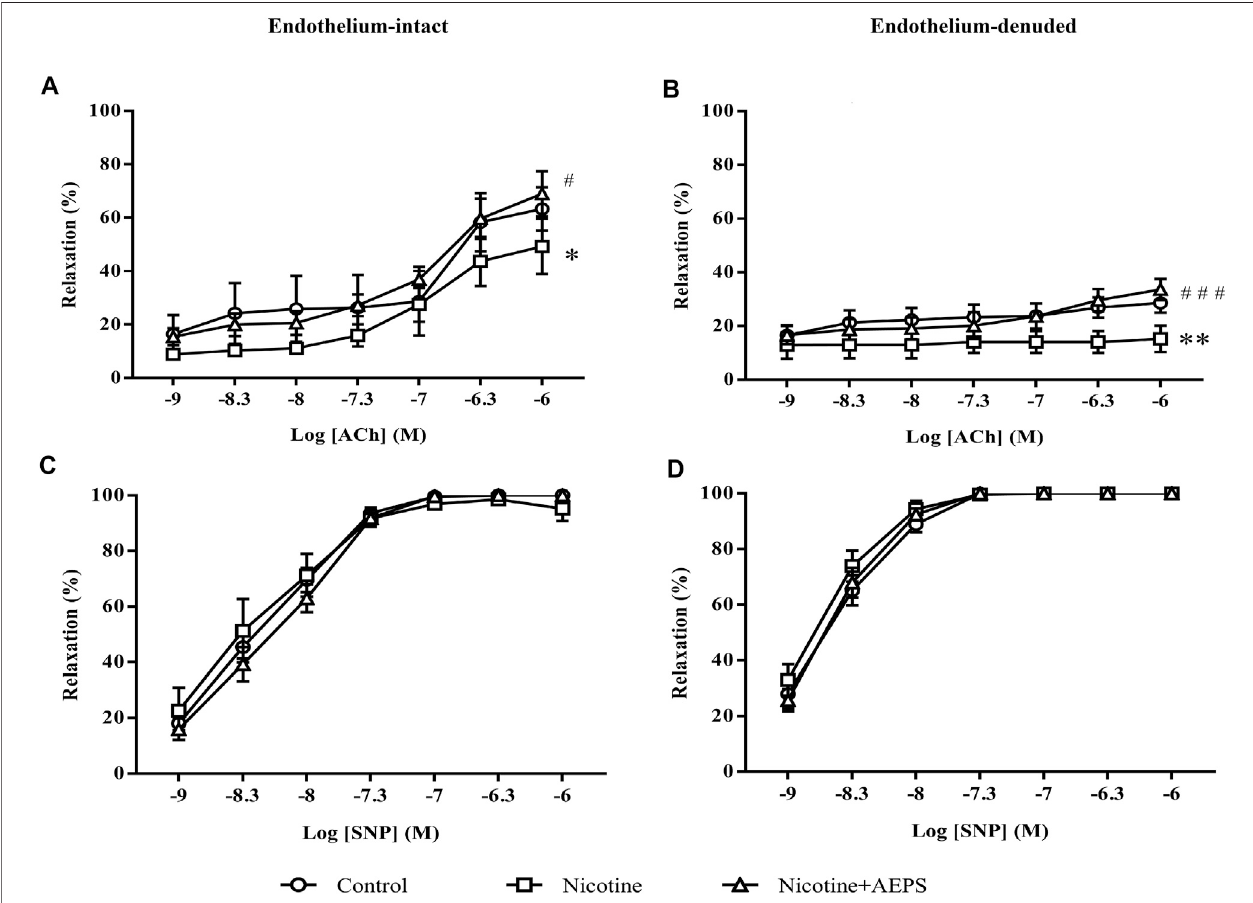
FIGURE 1 | Concentration-relaxation curves to the endothelium-dependent vasodilator ACh (A, B) and endothelium-independent vasodilator SNP (C, D) in rat aorticringsfromeachgroup.Thevaluesaregivenasmean ± SEM, n (cid:1) 6 – 8foreachgroup.* p < 0.05,** p < 0.01comparedwiththecontrolgroup; # p < 0.05, ### p < 0.001 compared with the nicotine group. (See Table 1 for comparison of maximum relaxation among the